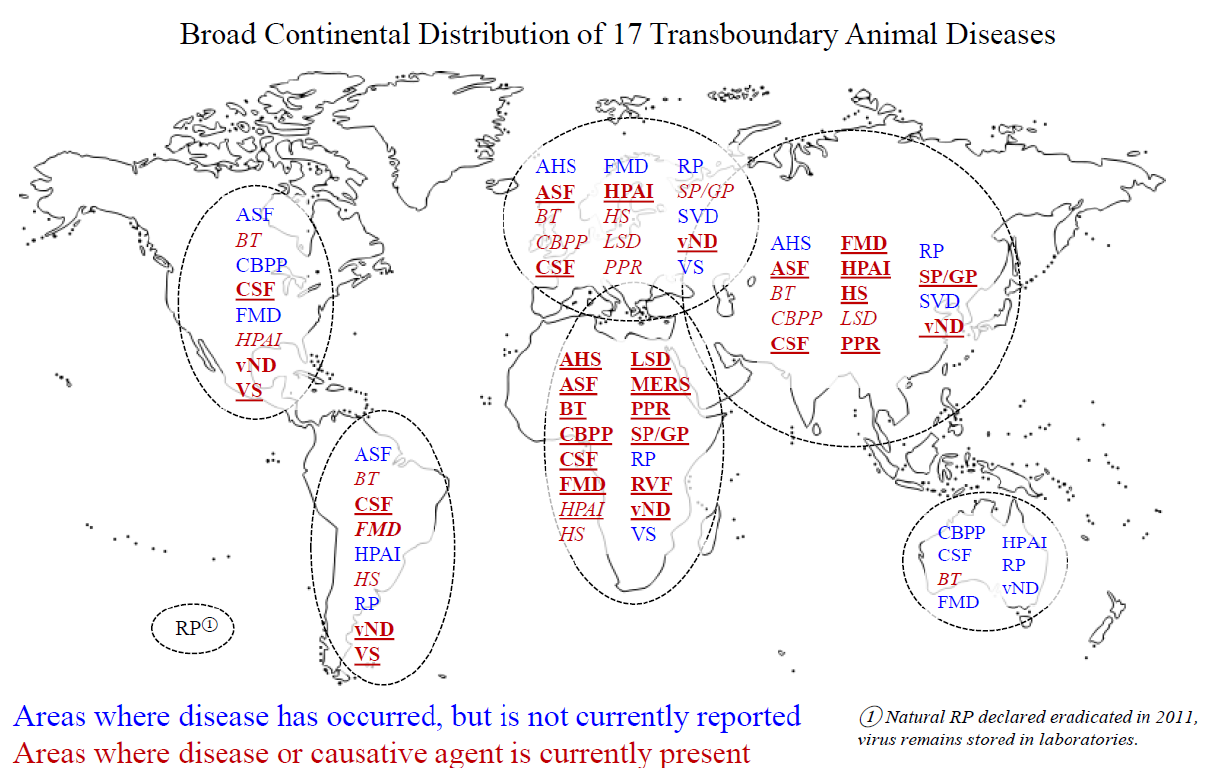
Figure 1. Broad continental distribution of 17 transboundary diseases. This figure displays a general and broad continental distribution of each disease. Due to the potential for these diseases to easily cross borders, the geographic distribution is divided into broad regions rather than being country specific. Abbreviations: African horse sickness (AHS), African swine fever (ASF), avian influenza (HPAI), bluetongue (BT), classical swine fever (CSF), contagious bovine pleuropneumonia (CBPP), foot and mouth disease (FMD), hemorrhagic septicemia (HS), lumpy skin disease (LSD), Middle East respiratory syndrome (MERS), Newcastle disease (VND), peste des petits ruminants (PPR), Rift Valley fever (RVF), rinderpest (RP), sheeppox and goatpox (SP/GP), swine vesicular disease (SVD), vesicular stomatitis